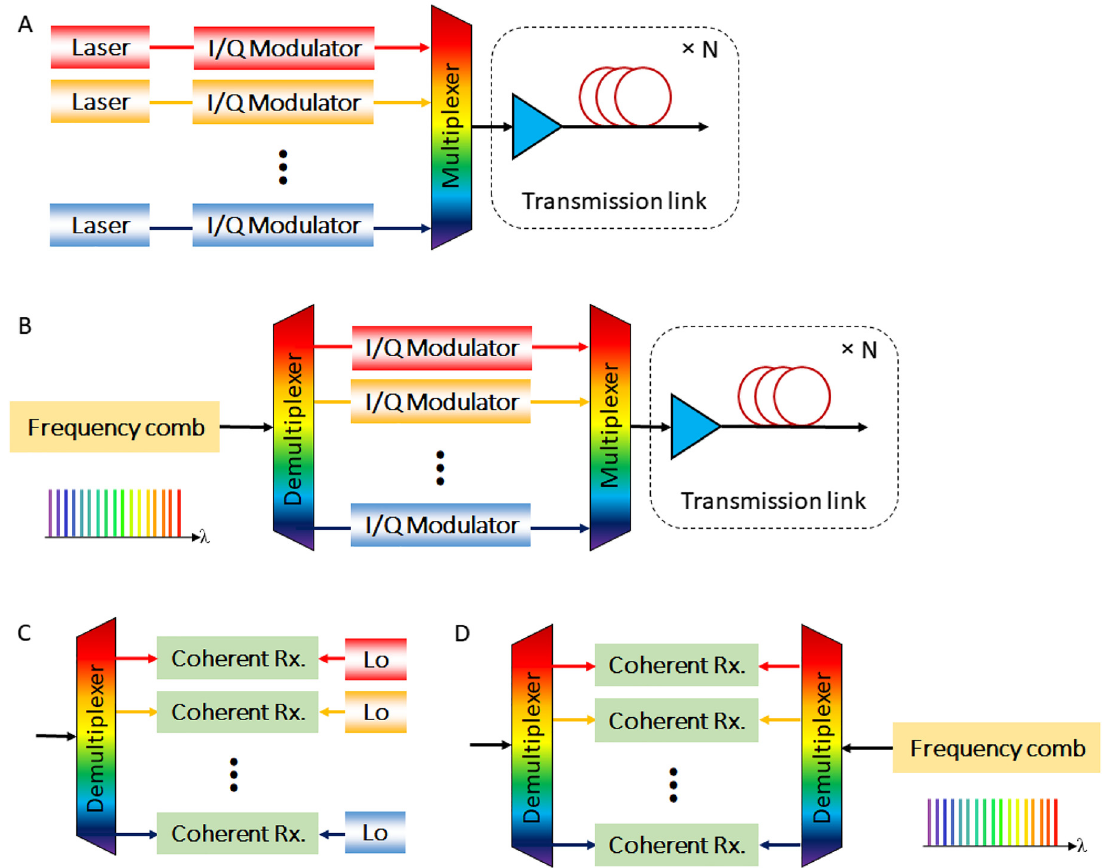
Figure 1: Schematic of high-speed WDM coherent optical communication systems. (A) Conventional WDM transmitter using individual lasers at different wavelengths as sources. (B) A frequency comb source-based WDM transmitter. (C) Conventional WDM coherent receiver using individual lasers as local oscillators (LOs). (D) A frequency comb source-based WDM coherent